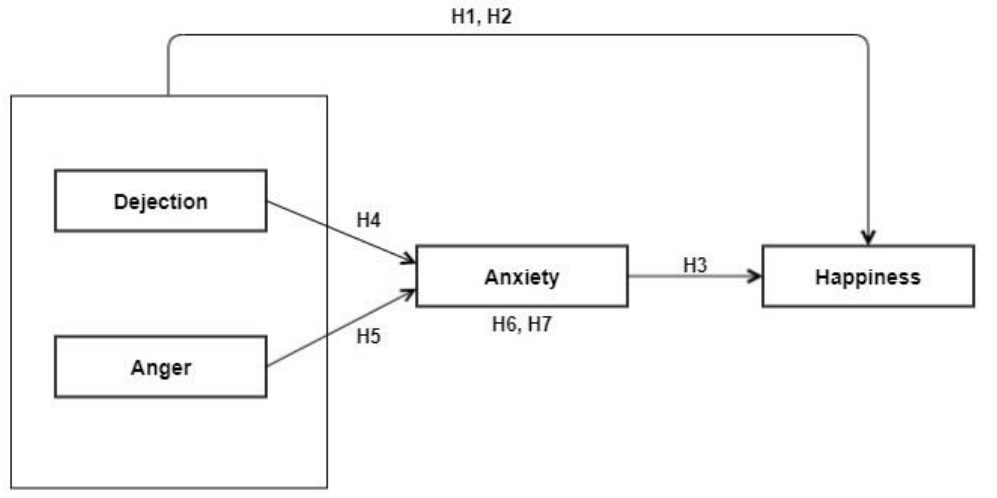
Figure 1. The hypothesized conceptual model.